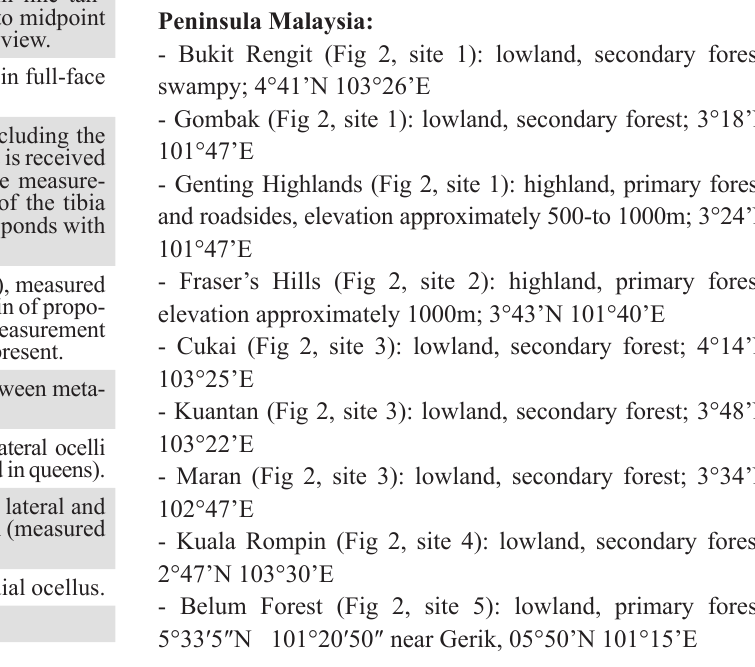
Dorsal postpetiole width: maximum width of post- DPPW petiole, measured in dorsal view. Dorsal petiole width: maximum width of the petiole, DPW measured in dorsal view. Eye length: measured along maximum diameter.